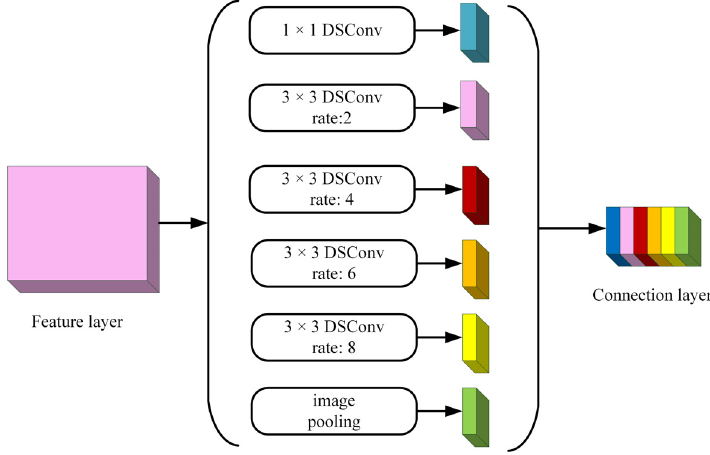
Figure 5. ASPP structure .